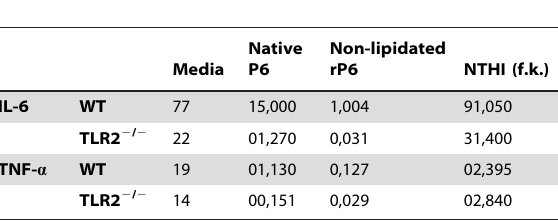
Native Non-lipidated Media P6 rP6 NTHI (f.k.) Table 2. Inflammatory cytokine secretion by BMDCs. a